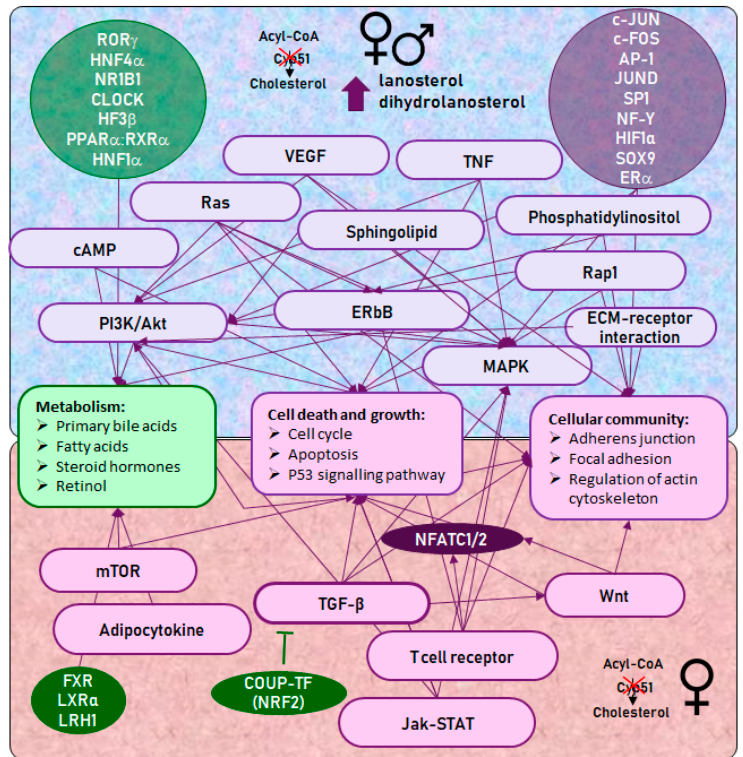
Figure 5. Hepatocyte-specific Cyp51 KO resulted in the deregulation of multiple signalling pathways and TFs, leading to the development of female-prevalent liver cancer. Arrows indicate connections between KEGG signalling pathways, TFs, and cellular processes. KEGG pathways and TFs are violet if positively enriched and green if negatively enriched at 24M. Top half—selected KEGG signalling pathways and TFs that were deregulated in females and males, leading to the inhibition of basic metabolism and an increase in processes of cell death and growth, and cellular communication. MAPK and PI3K / Akt signalling pathways have a central role and are regulated by other signalling pathways and TFs, all directly or indirectly contributing to carcinogenesis. Bottom half—female-specific KEGG signalling pathways and TFs. TF NFATC1 / 2 is central to the female-specific phenotype and is connected by the TGF- β , mTOR and Wnt signalling pathways, positively enriched only in female Cyp51 KO